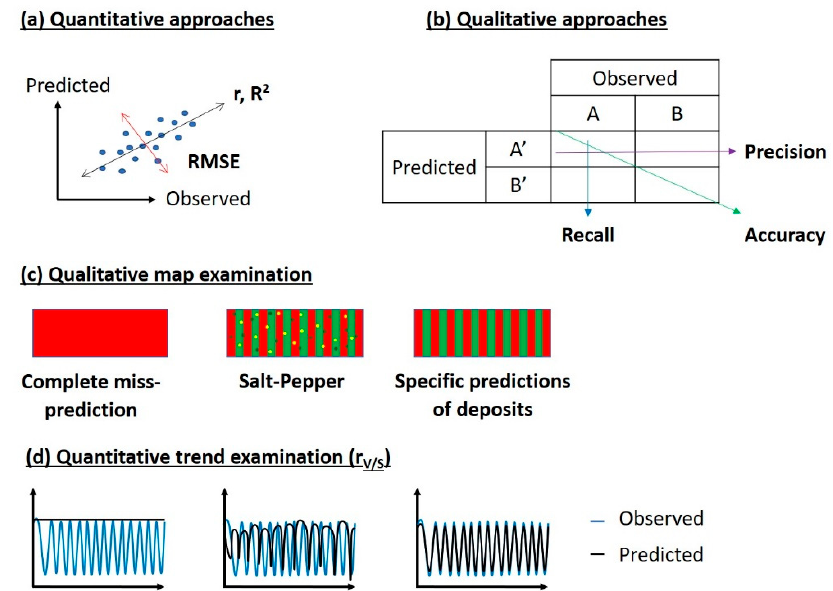
Figure 12. Schematic representation of quantitative validation parameters for ( a ) regression or ( b ) discrimination approaches, as well as ( c ) qualitative for map evaluation and ( d ) quantitative for prediction profiles.